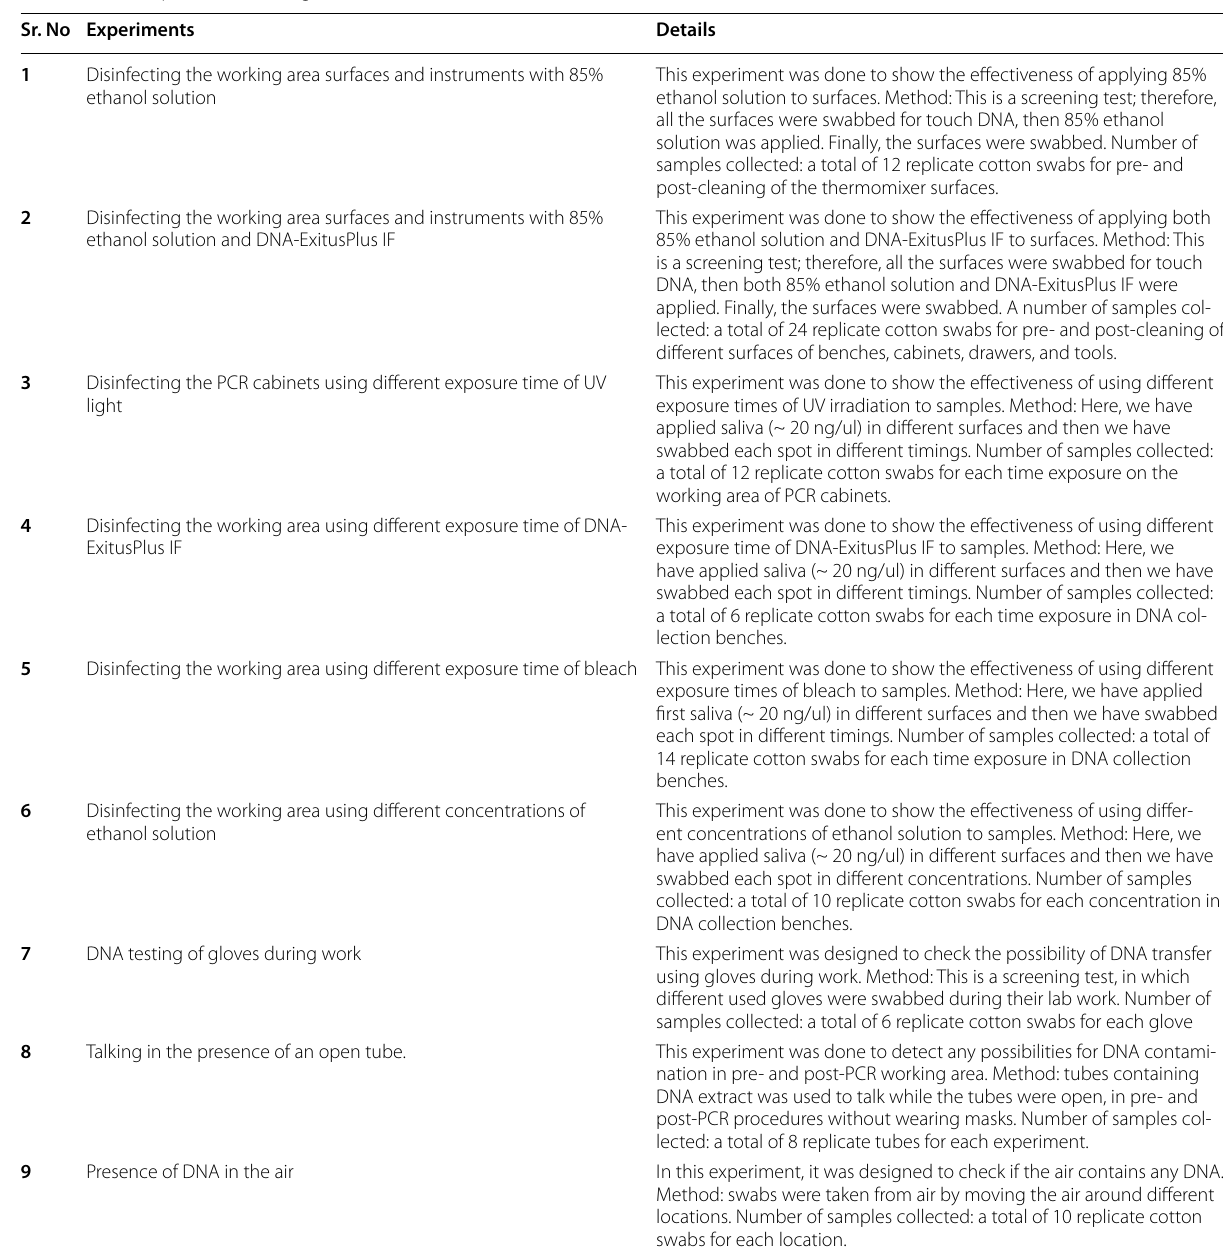
Table 1 The experimental